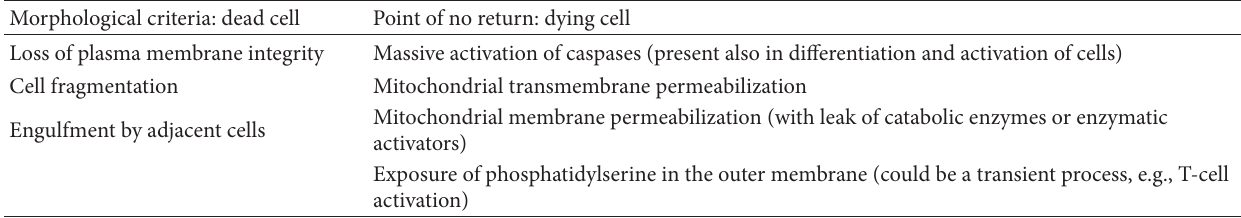
Table 1: Cell death.